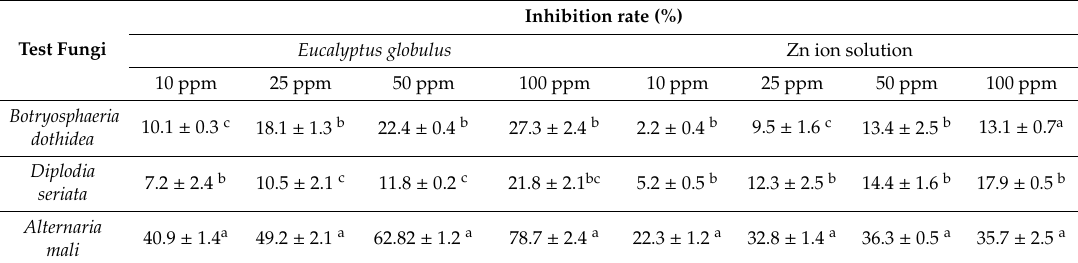
Table1. In vitroinhibitoryrate(%)ofphytopathogenicfungiusingdi ff erentconcentrationsof Eucalyptus globulus leaf extract and Zn ion solution.